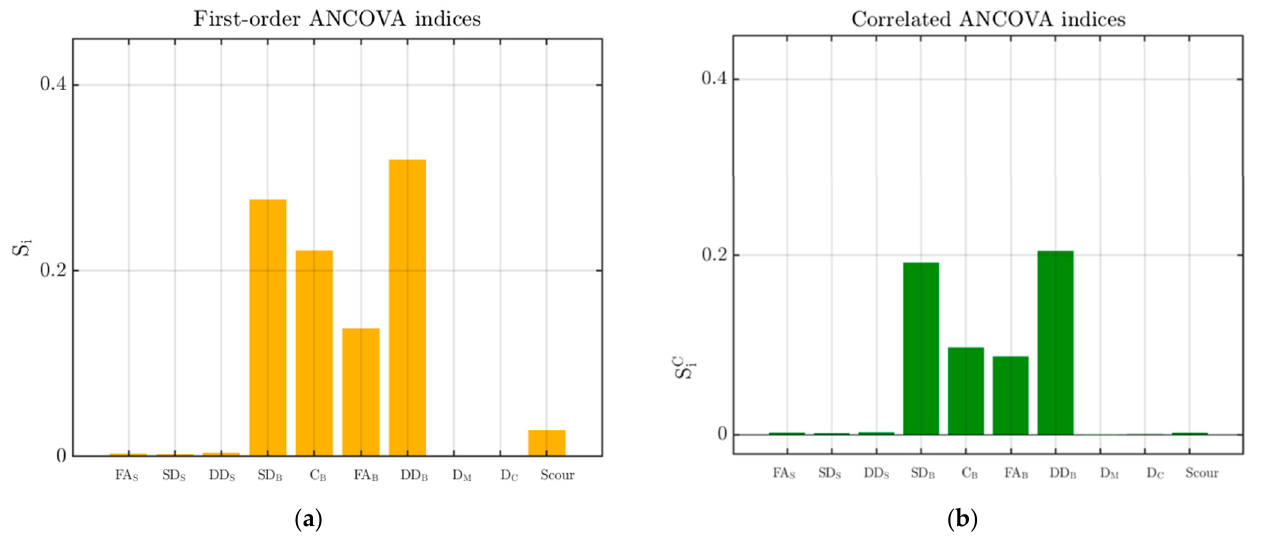
Figure 6. ANCOVA indices: ( a ) First order; ( b ) correlated.